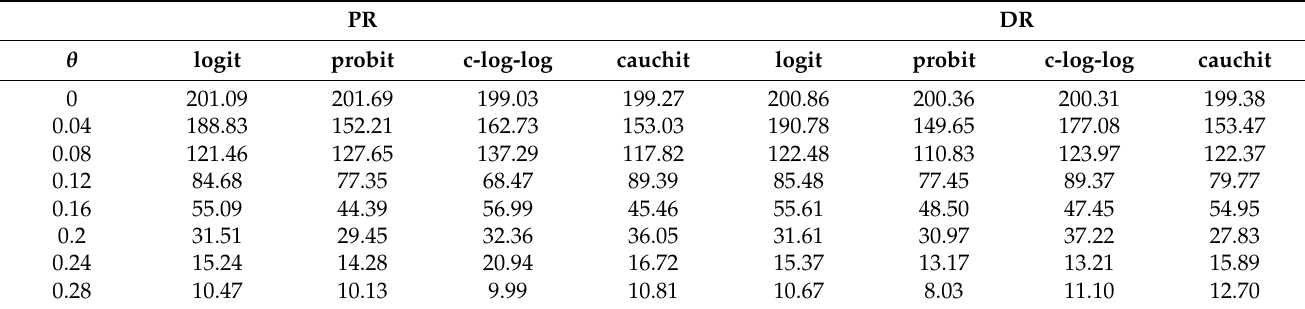
Table 3. Performance of ARL 0 = 200 with shift in β 1 under considered link functions. PR